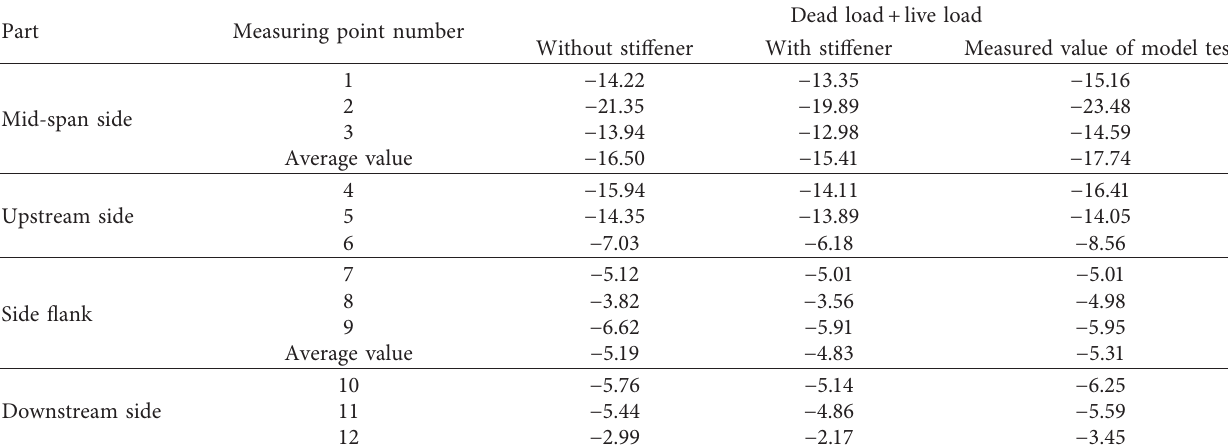
Downstream side